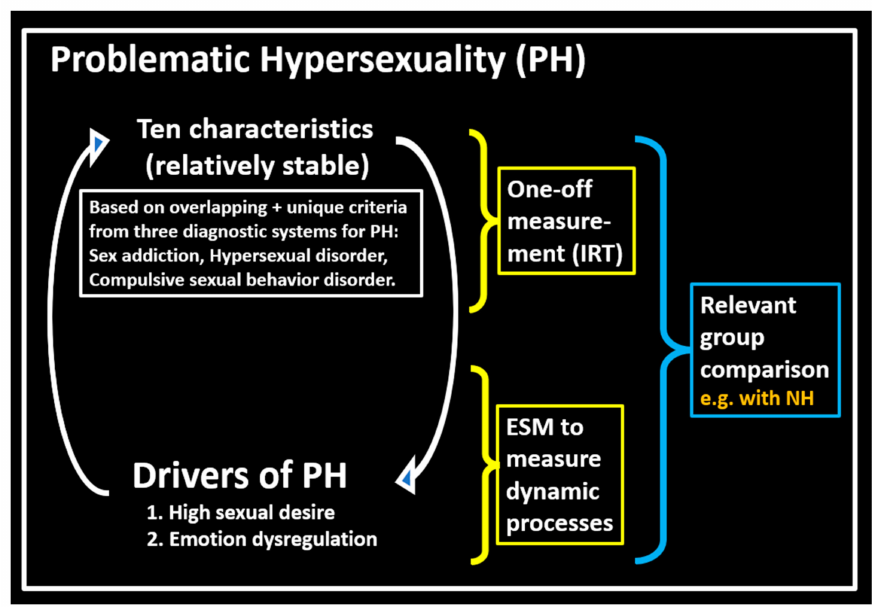
Figure 1. Decentralized Construct Taxonomy (DCT [4]) of Problematic Hypersexuality. Model of the DCT definition for PH (https://psycore.one/construct/?ucid=problematicHypersexuality_ 7mm4hr4f, accessed on 31 January 2023). This DCT implies an extensive, explicit, testable and preliminary definition for PH and includes remarks on how to measure PH. Ten relatively permanent characteristics of PH are seen as driven by high sexual desire and emotion dysregulation in this definition. Stable traits are best measured with IRT-validated one-off instruments, while dynamic processes (the drivers) are best assessed with ESM techniques. IRT and ESM research should be undertaken with relevant group comparisons in